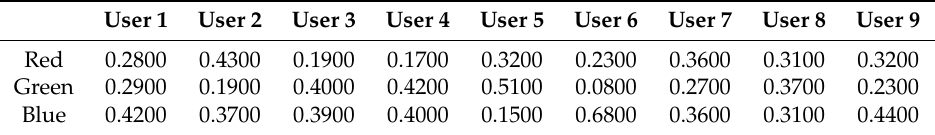
Table 2. Transactions price for each user toward the three categories of data.